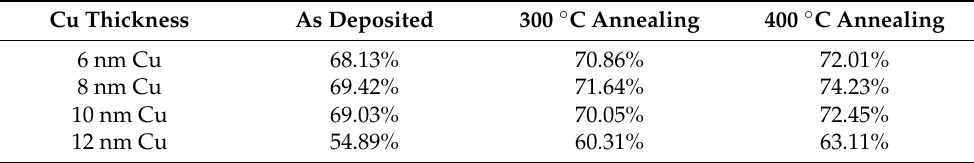
Figure 1. Transmittance spectra of ( a ) as-deposited multilayers and multilayers ( b ) annealed at 300 °C and ( c ) 400 °C. ( d ) Average transmittance of multilayers as a function of Cu thickness. Table 1. Summary of average transmittance of multilayers at visible wavelengths (from 400 to 700